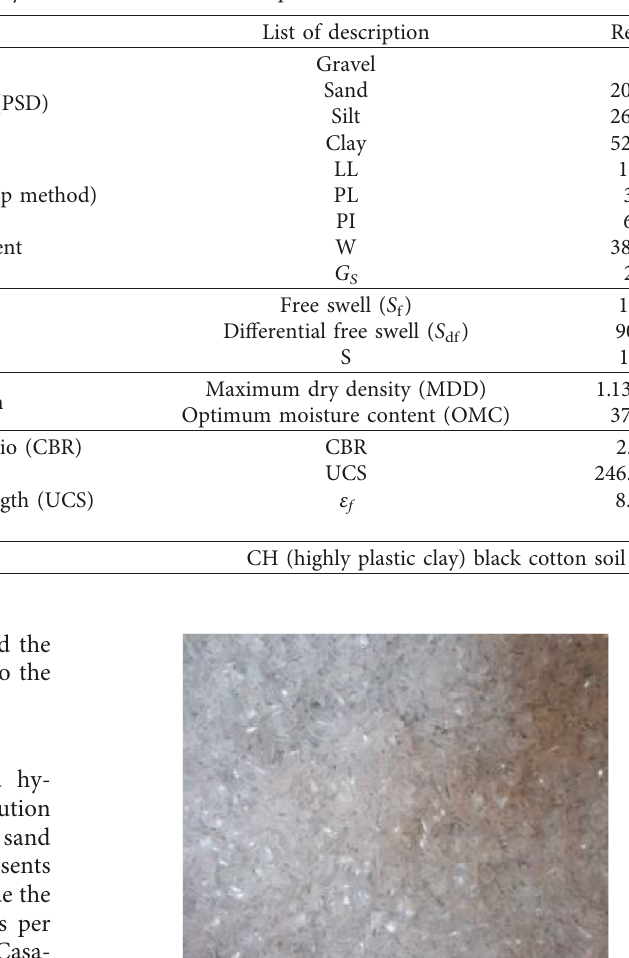
Table 1: Laboratory result of a natural soil sample.